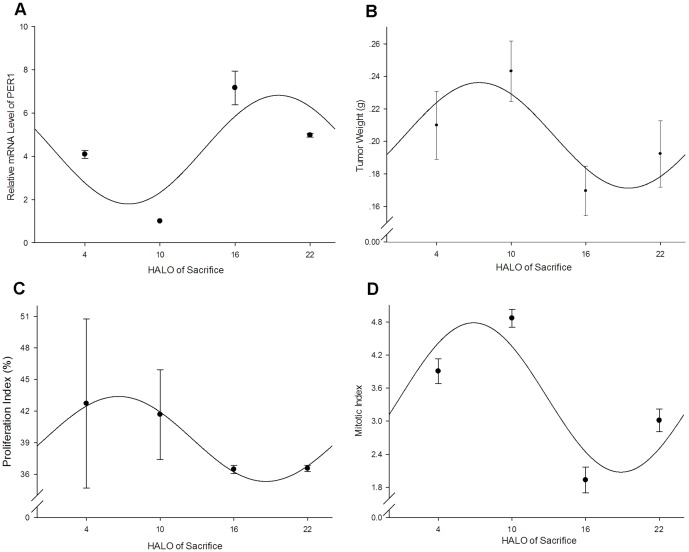
Cosine fitted curves of the circadian variations of PER1 mRNA expression, tumor weight, PI, MI of tumor bearing mice.A: relative PER1 mRNA expression, the average of the lowest relative PER1 mRNA amount was set as 1. β-actin is detected as an internal control; B: tumor weight; C: PI of tumor cells; D: MI of tumor cells. Points, mean with 24 h cosine fitted curves; bars, SD. Note that there is a break in the vertical axis.